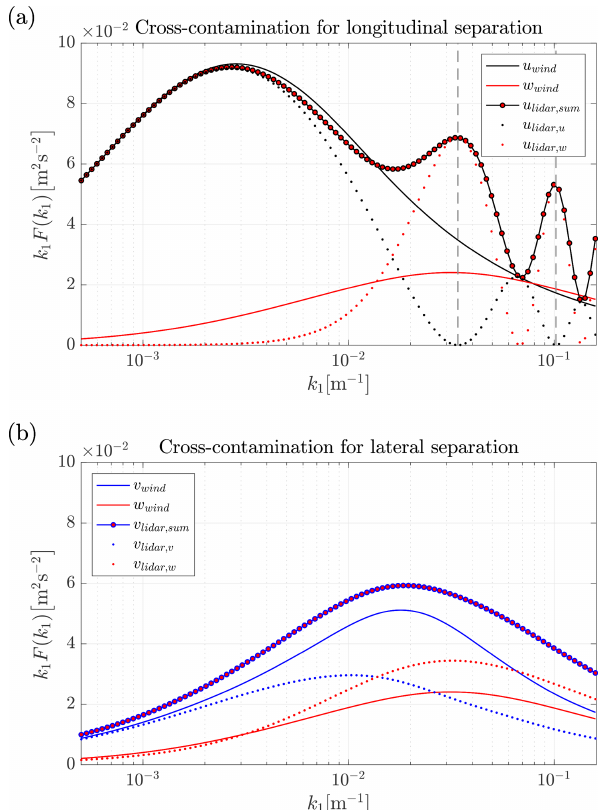
Figure 3. Modeled cross-contamination effect inherent in (a) the u spectrum from two longitudinally separated points with (cid:49)x = D C and (b) the v spectrum from two laterally separated points with (cid:49)y = D C . The solid lines are the spectra of the involved wind com- ponents. The dotted lines show the contribution of these wind com- ponents to the lidar spectra (circle markers). Averaging along the lines of sight is